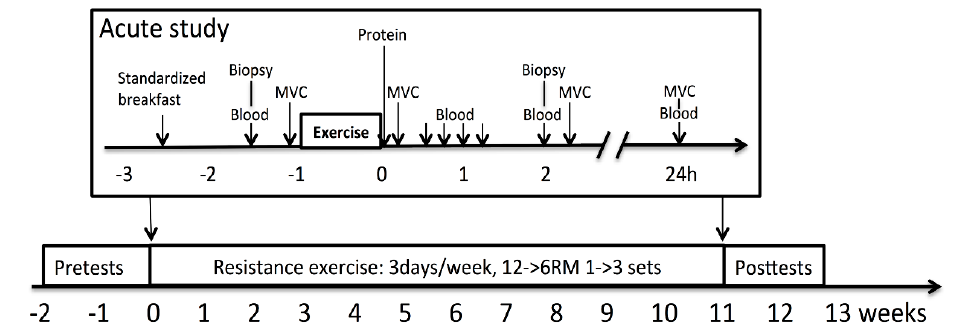
Figure 2. Timeline of the study.